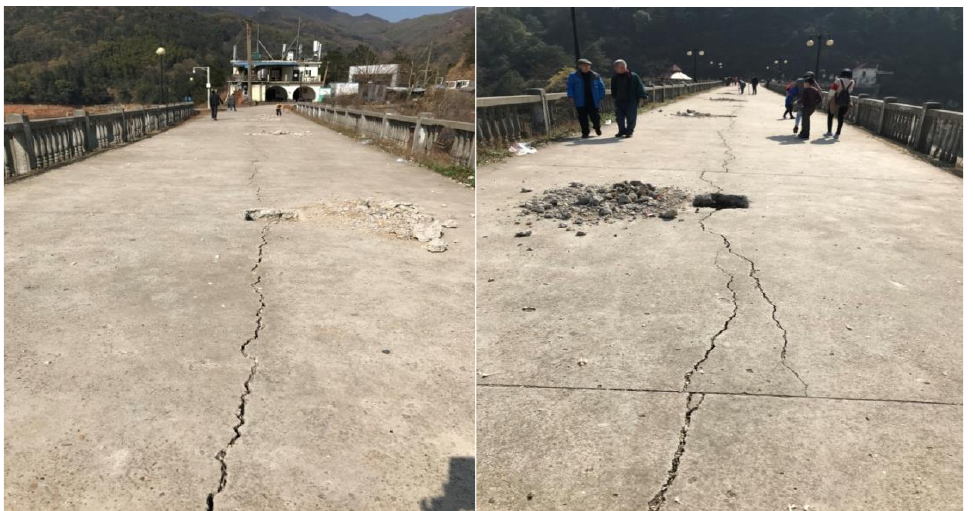
Figure 1. Dam crest of Wujing reservoir. The dam is a homogeneous earth dam. After the construction of the concrete high- pressure jet grouting cut-off wall, the dam crest elevation is 192.55 m, the maximum dam height is 45.4 m, and the dam crest is 181 m long and 8 m wide. The normal pool level is 190 m, the design flood level is 190 m, the check flood level is 190.16 m, and the total storage capacity is 4.48 million m 3 . From 183 m elevation to dam crest elevation, precast block slope protection is adopted for the upstream slope of the dam, with a slope ratio of 1:2; From the elevation of 170 to 183 m, the upstream slope of the dam adopts dry masonry slope protection, with a slope ratio of 1:2.5. Below the elevation of 170 m, the upstream slope of the dam is a block stone prism with a slope ratio of 1:1.25. From the elevation of concrete grid turf. Below the elevation of 171 m, the downstream slope of the dam is sloped for drainage, as shown in Figure 2.